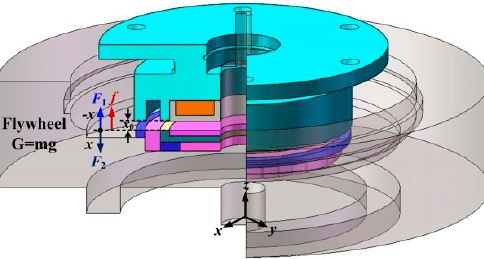
Figure 3. The analysis of A-HMB system. (Note: the direction of the arrow in the figure only represents the direction of displacement, and the actual direction of the forces are all vertical upward.)